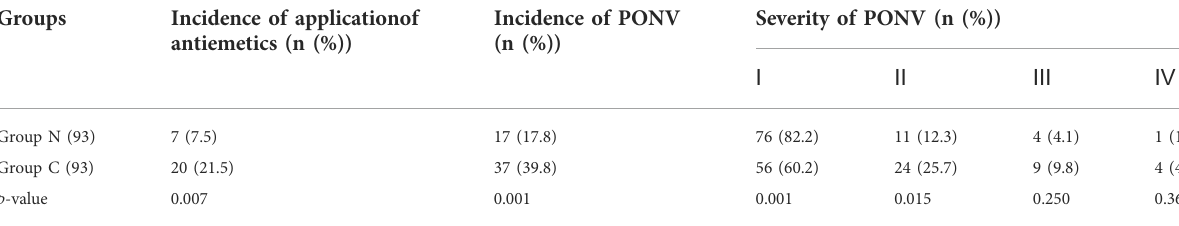
TABLE 6 Severity of PONV and Incidence of PONV and application of antiemetics within 24 h after operation between the two groups (n (%)).